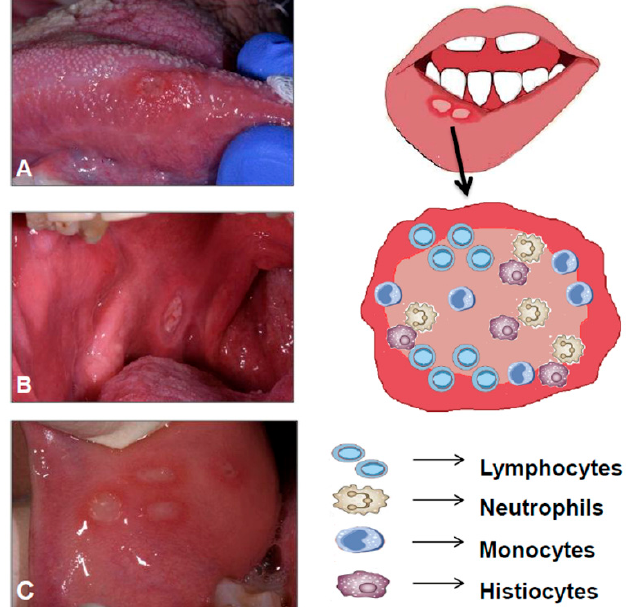
Figure 3. Aphthous-like ulcers: histopathological features. Left: These images show some typical features of ALU: round or oval ulcer covered by a yellow-white fibromembrane with a peripheral erythematous halo; margins may appear indurated and elevated ( A : ALU in the right side of the tongue; B : ALU in the posterior buccal mucosa; C : Four concomitant ALU in the anterior buccal mucosa). Right: The ulcerative lesion shows an increased angiogenesis and a mixed inflammatory infiltrate that consists of various leukocytes (lymphocytes, neutrophils, monocytes and histiocytes).